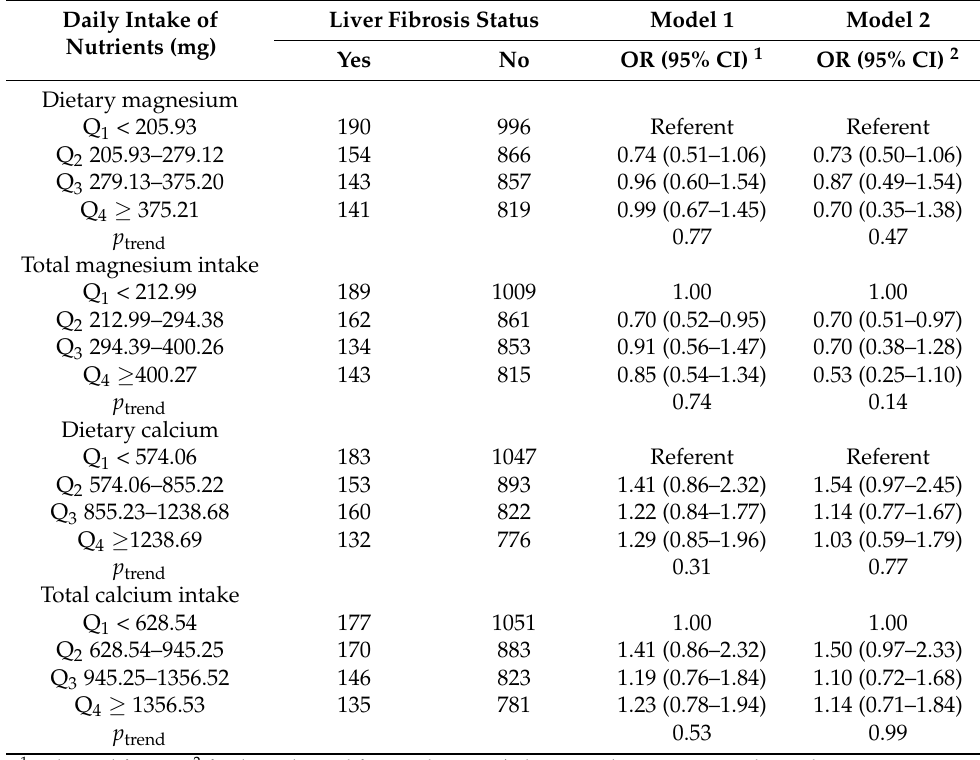
Table 2. Associations between intakes of magnesium and calcium and odds of significant liver fibrosis, NHANES 2017–2018.